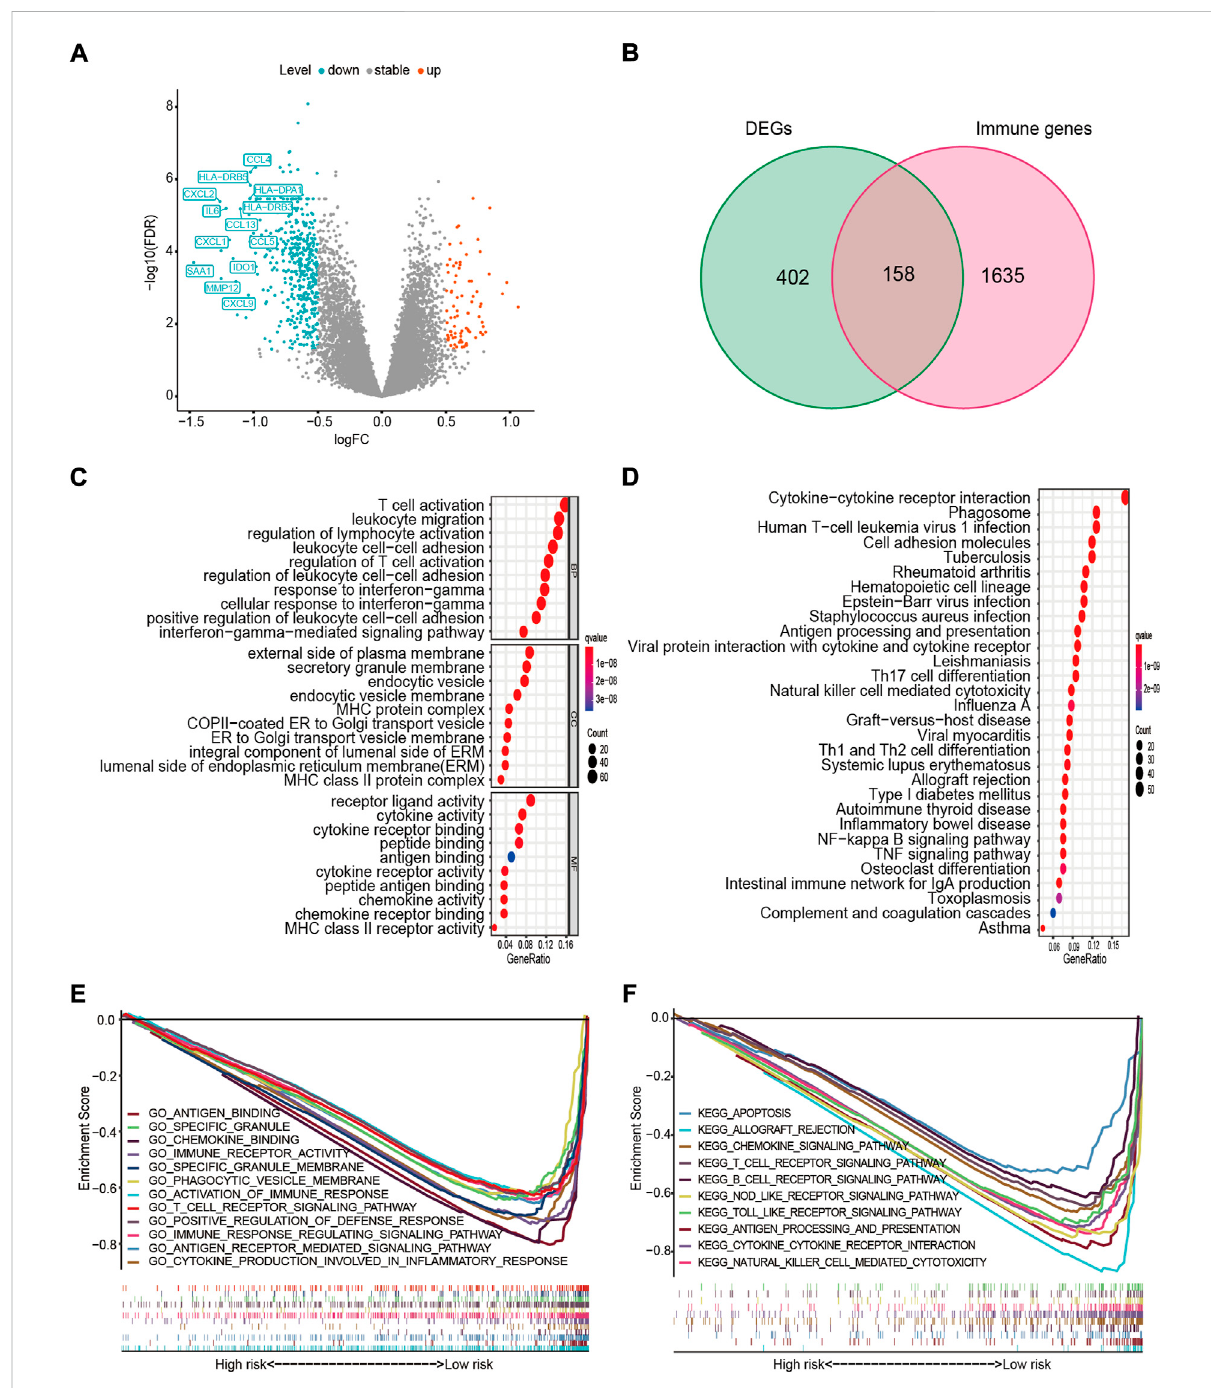
FIGURE 8 Functional enrichment and pathway analyses. (A) Volcano plot of 560 DEGs. Upregulated immune-related DEGs with p < 0.05 and |log2FC| > 1 in the low-risk group are presented (left). (B) Venn diagram of DEGs and IRGs. (C) The top 10 GO terms in molecular function (MF), cellular component (CC), and biological process (BP). (D) The top 30 enriched KEGG pathways. (E) Most signi fi cant GSEA sets, from GO-related MSigDB, associated with the low-risk group. (F) Most signi fi cant GSEA sets, from KEGG-related MSigDB, associated with the low-risk group. DEG, differentiallyexpressed gene;FC,foldchange;IRG,immune-relatedgene;GO,GeneOntology;KEGG,KyotoEncyclopediaofGenesandGenomes; GSEA, gene set enrichment analysis; MSigDB, The Molecular Signatures